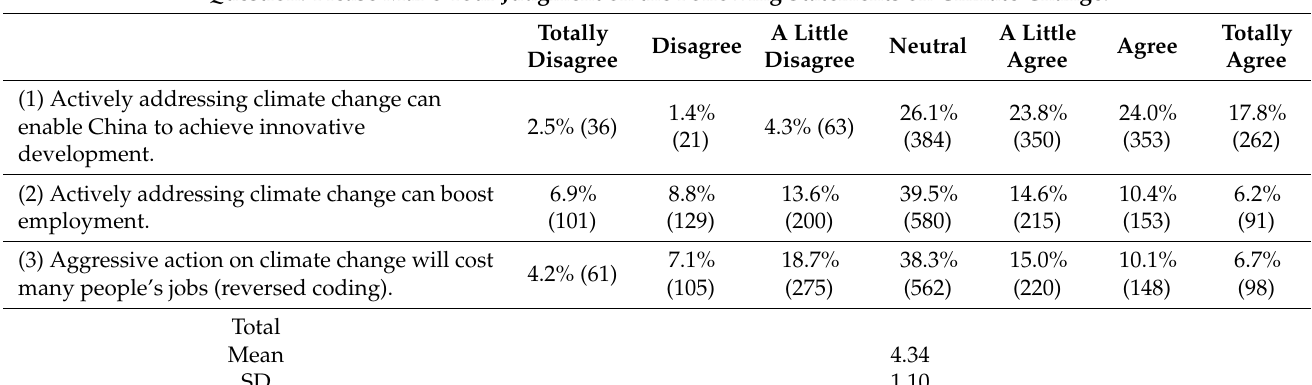
Table 3. Participants’ climate benefit perception ( n =